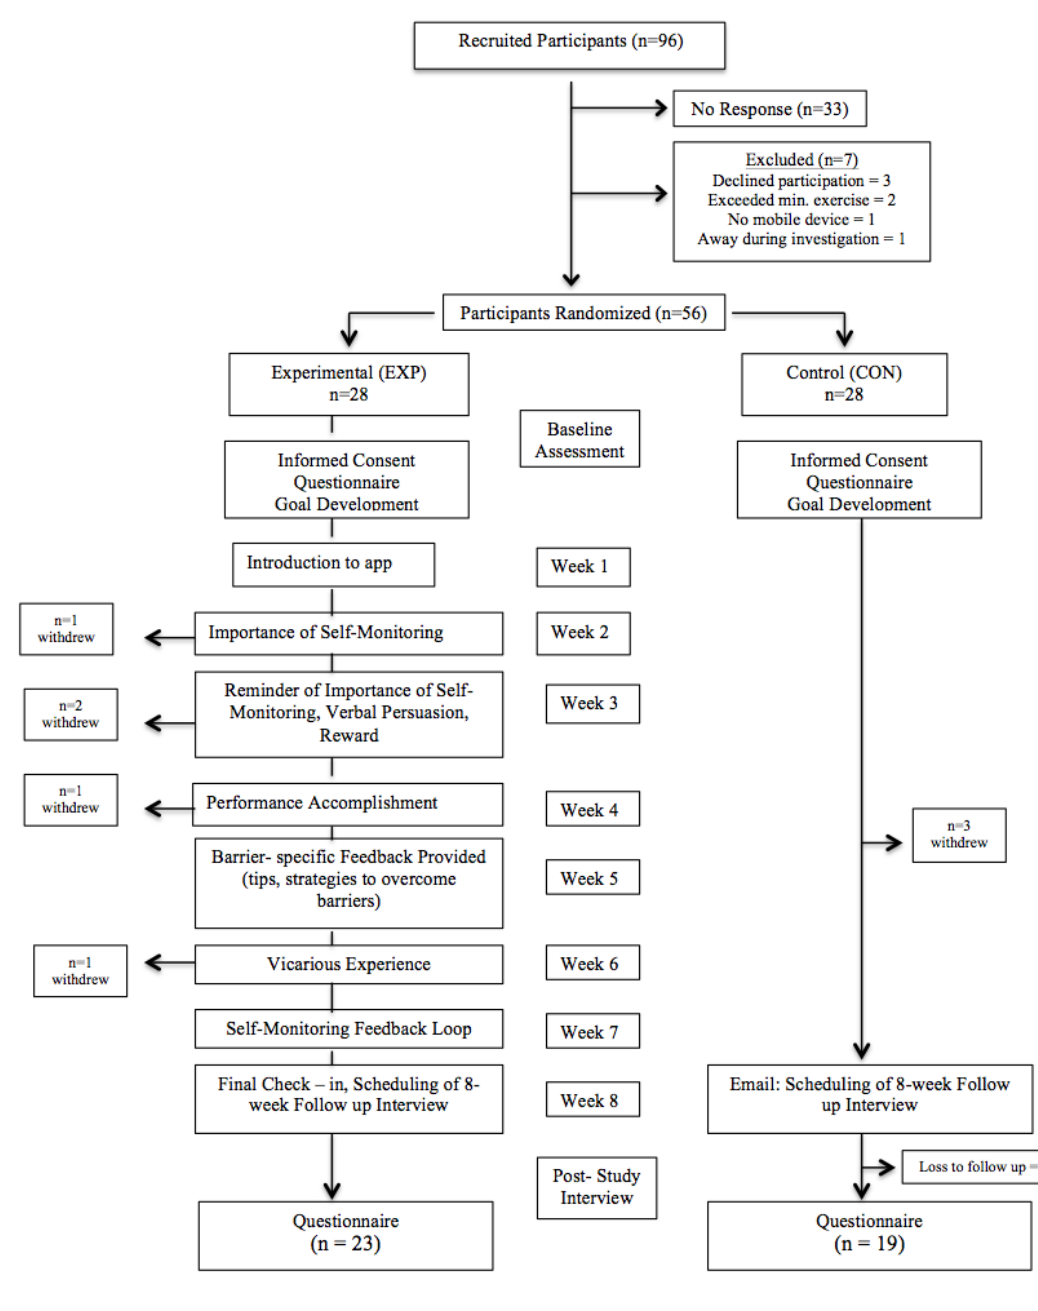
Figure 1. Participant